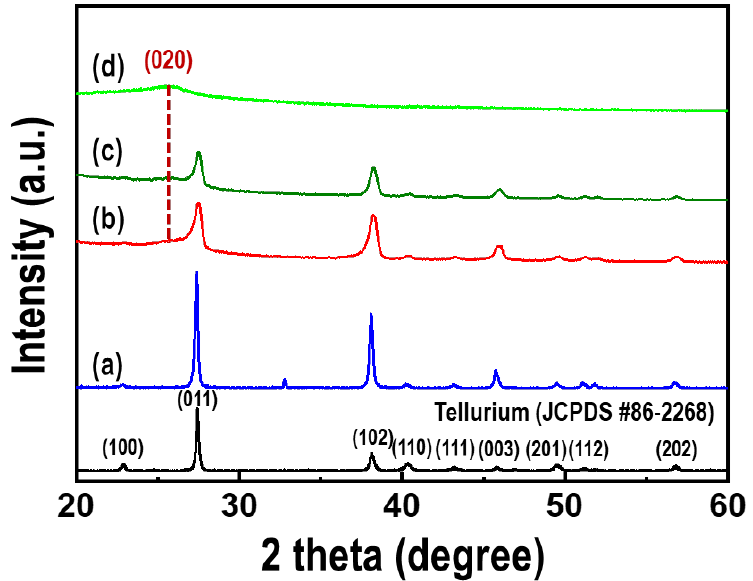
Figure 5. XRD patterns of ( a ) the Te nanorod arrays, PEDOT/Te composite films with polymerization time of ( b ) 15 s and ( c ) 30 s, ( d ) PEDOT film. The black line represents a standard peak of the tellurium (JCPDS No. 86-2268).